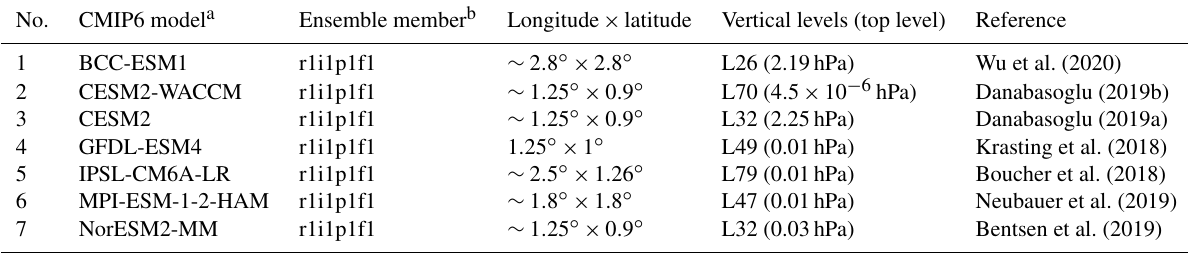
Table 3. Information on the CMIP6 models used in this study.